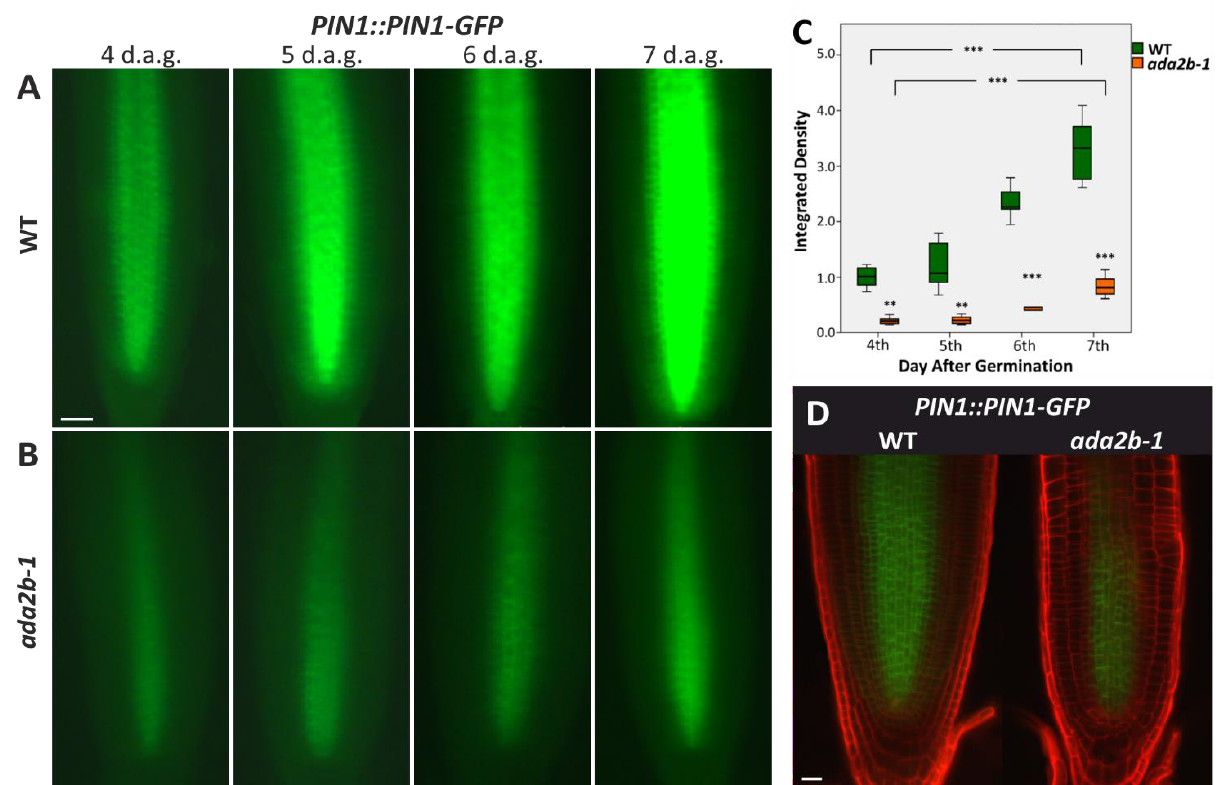
Figure 2. ADA2b affects PIN1 expression during early root growth in Arabidopsis thaliana . The expression of reporter gene PIN1::PIN1-GFP in roots of ( A ) wild type (WT) and ( B ) ada2b-1 mutant plants at the fourth, fifth, sixth and seventh day after germination (d.a.g.). Scale bars represent 50 µ m. ( C ) Graphical representation of fluorescence density between WT and ada2b-1 . The bars represent the range of the two quadrants. The horizontal line in the bar is the median, while the terminals are the minimum and maximum values of the data. Asterisks above bars of ada2b-1 indicate statistical significance compared to the same d.a.g. of WT. Asterisks between brackets show the difference between the fourth and seventh d.a.g., using an independent samples t -test: ** p < 0.01, and *** p < 0.001. ( D ) Confocal microscopy for PIN1::PIN1-GFP expression in 7-day-old roots of WT and ada2b-1 after PI staining. Scale bars are 20 µ